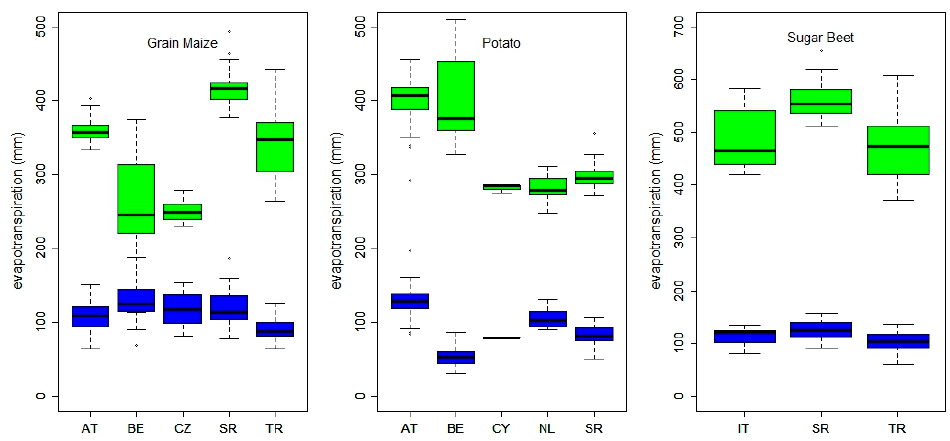
Figure 7. Transpiration ( T in mm, green) and evaporation ( E in mm, blue) for irrigated summer crops across the European regions for the period 1992–2012. A two letter code refers to the country that the region belongs to.